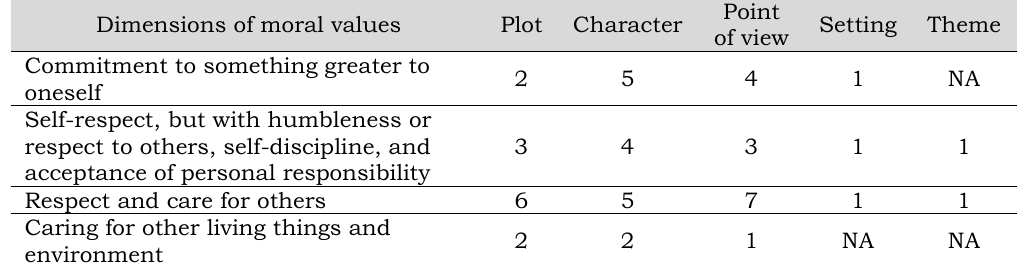
Table 1. Number of moral values derived from the intrinsic structures Dimensions of moral values